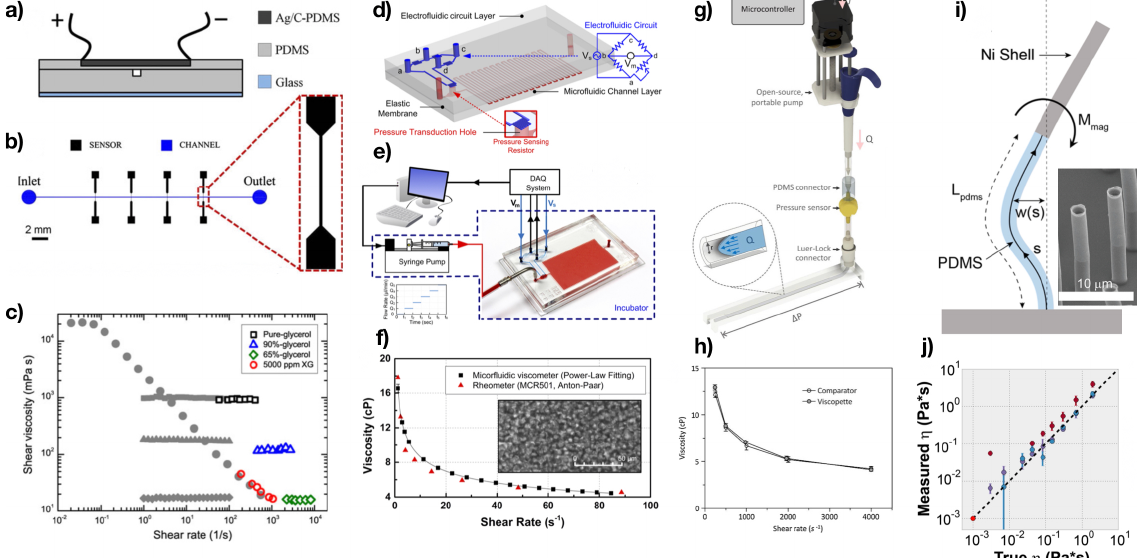
Figure 2. Examples of Micro-Electro-Mechanical Systems (MEMS) employed in microfluidic rheome- try. ( a , b ) Schematic of the microfluidic rheometer made of PDMS with pressure sensors also made of flexible PDMS containing silver and black carbon conductive particles. ( c ) Good agreement between conventional and microfluidic rheometry data using the apparatus in ( a , b ). Reprinted with permis- sion from Springer Nature: Rheologica Acta, Pan and Arratia, Copyright (2013) [17]. ( d , e ) Schematic of the microfluidic device with an electrofluidic circuit employed as pressure sensor. ( f ) Good agree- ment was observed between bulk and microfluidic viscosity data for whole blood samples. The inset is a real-time image of blood cells in the microfluidic channel. Reprinted with permission from Lee et al., Analytical chemistry, 90, 2317–2325 [18]. Copyright 2018, American Chemical Society. ( g ) Schematic of the hand-held, automatic capillary viscometer. ( h ) Good agreement was observed between bulk and microfluidic viscosity data for xanthan gum 1.0 wt% solutions. Reprinted from Sensor and Actuators:B, 313, 112176, Lee et al., hand-held, automatic capillary viscometer for analysis of Newtonian and non-Newtonian fluids [19], Copyright (2020), with permission from Elsevier. ( i ) Schematic of a microfluidic viscometer using magnetically actuated micro post arrays. ( j ) Good agreement was observed between bulk and microfluidic viscosity data for sucrose and Karo solutions. Reprinted from Judith et al.